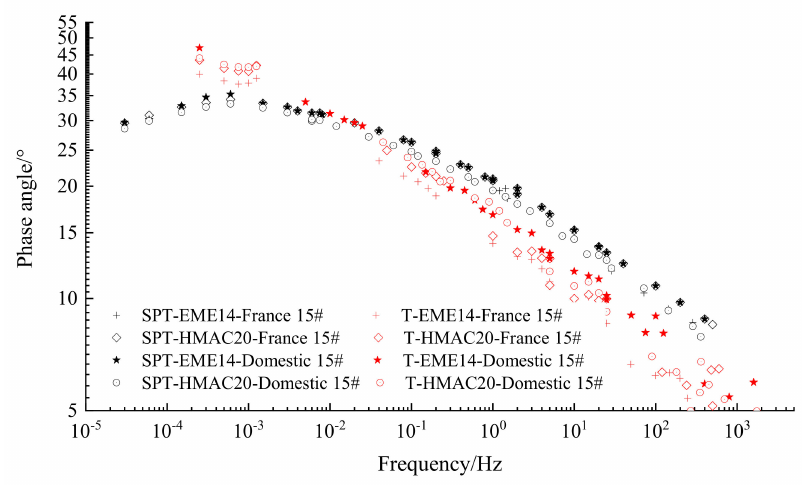
Figure 6. Phase angle master curves of high-modulus mixtures with different test